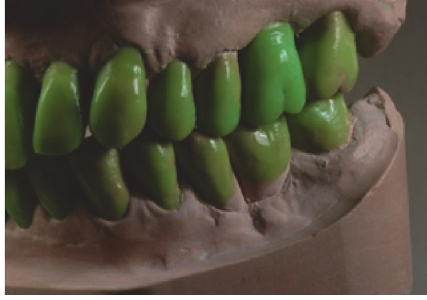
Figure 9: Diagnostic wax-up, lateral left view.